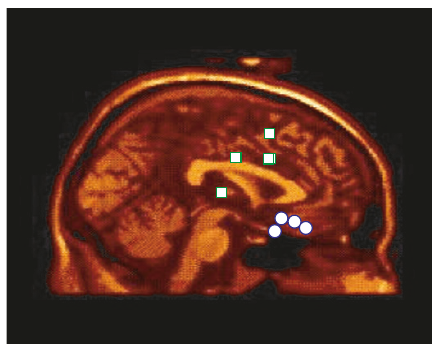
Figure 12: Localisation result for normal subjects. The circles cor- respond to P3a and the squares to P3b. The P3a and P3b sources are located in distinct regions in the